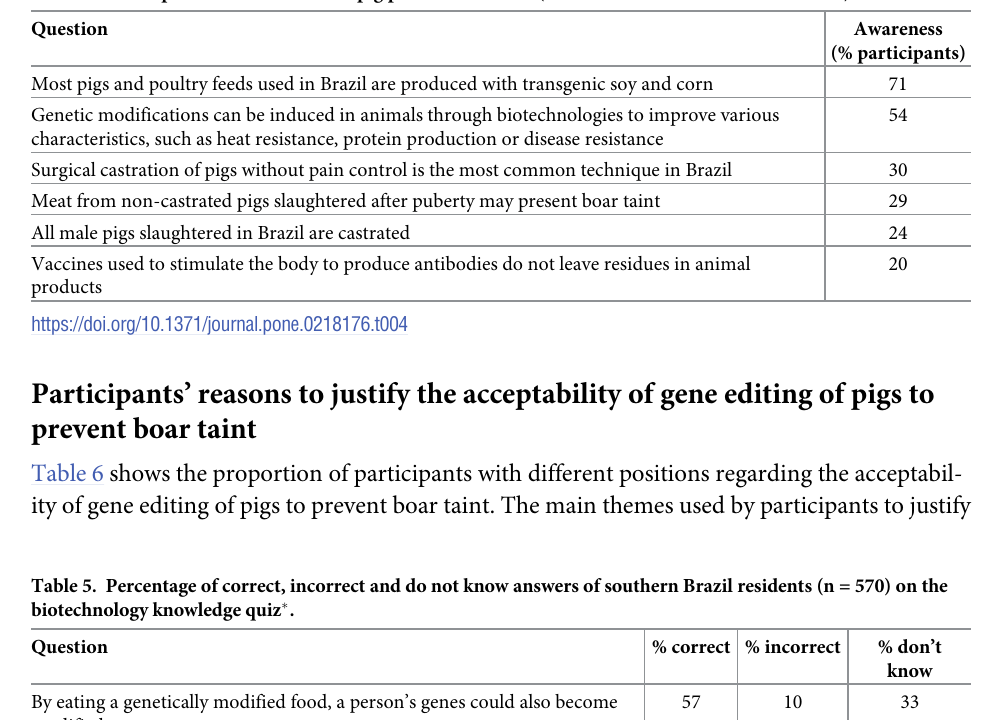
Table 4. Participants’ awareness on six pig production issues (n = 570 southern Brazilian residents).